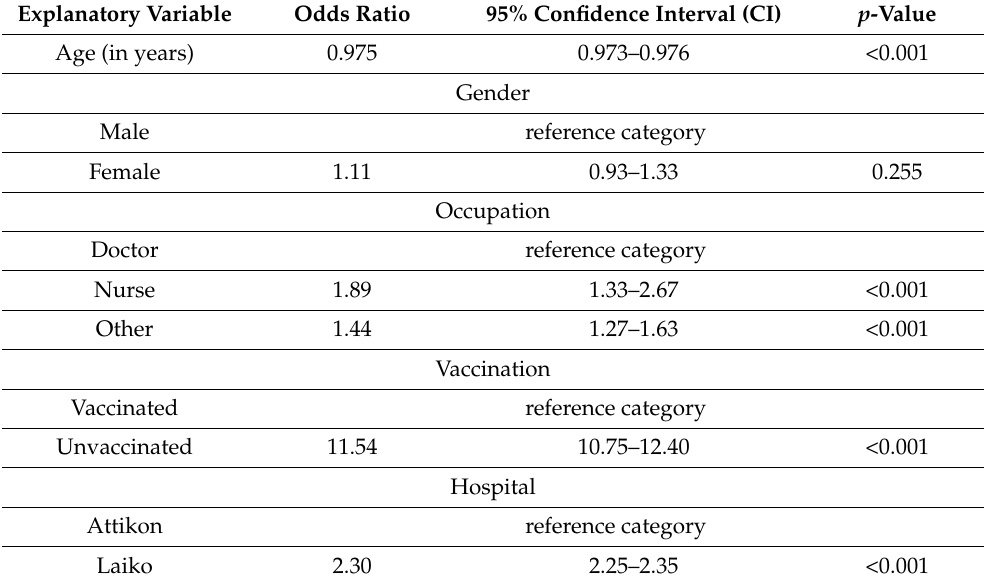
Table 4. Multivariable logistic regression estimates using the SARS-CoV-2 infection as the binary outcome variable ( n =